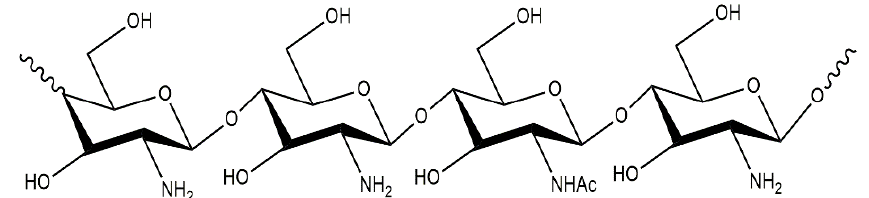
Figure 2. Chitosan